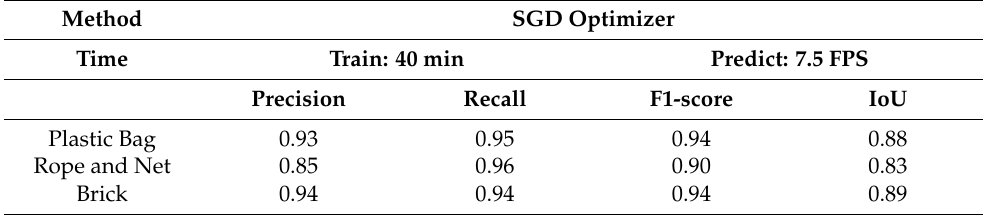
Table 7. Results of SGD optimizer.